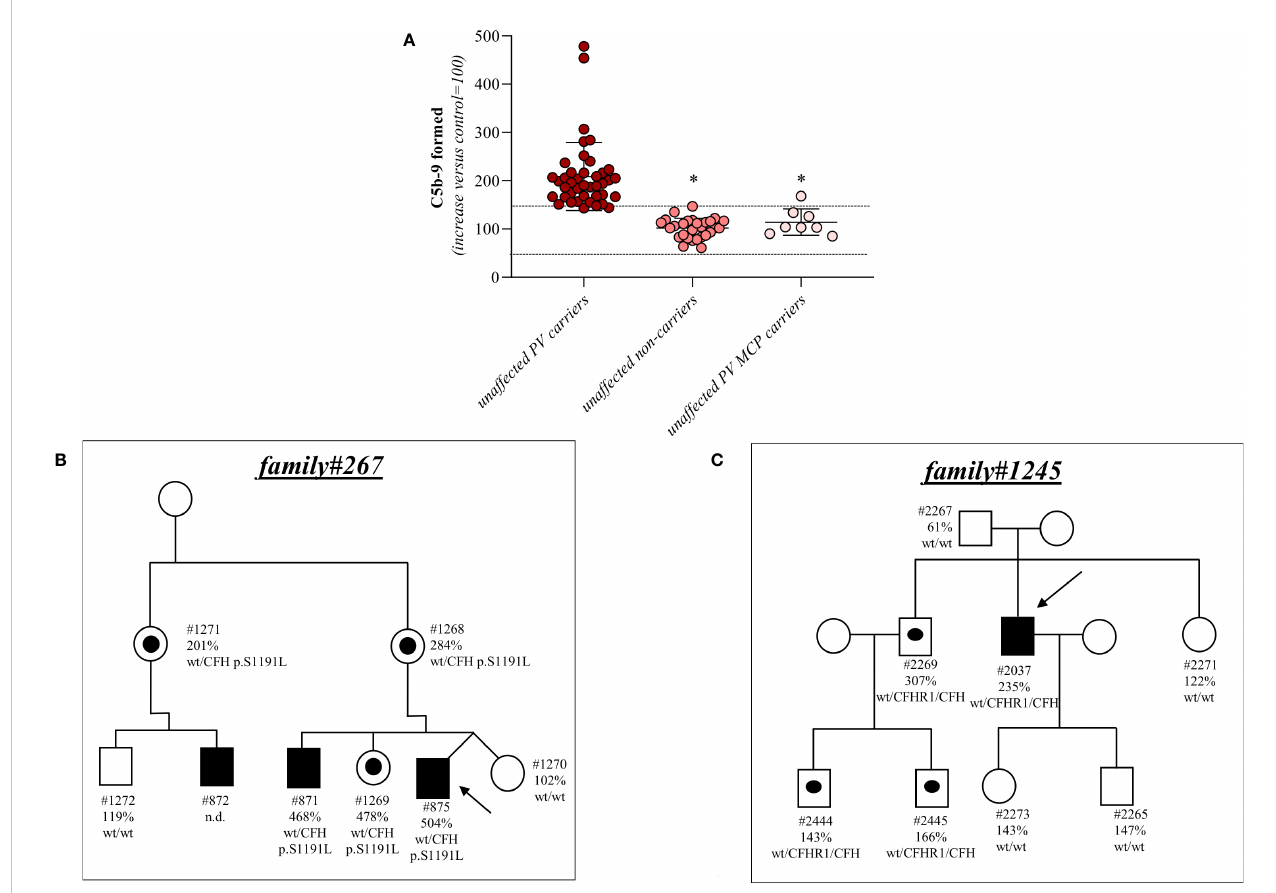
FIGURE 2 Serum from unaffected relative carriers of PV induces higher than normal C5b-9 formation on HMEC-1. (A) Endothelial surface area covered by C5b-9 staining after 2h incubation of ADP-activated HMEC-1 with serum (diluted 1:2 in test medium) from either unaffected carriers of PV in genes encoding for fl uid phase complement proteins (n=41), or from unaffected non-carriers of PV (n=28) or from unaffected carriers of PV in the MCP gene only (n=8). The results are shown as the fold increase of stained surface area after incubation with serum from unaffected carriers versus control pool of sera run in parallel. Points represent fold increase values of single subjects. Horizontal bars are mean ± SD values. Dotted lines are upper and lower limits of normal range. *P<0.0001 vs. unaffected carriers of PV. (B) Pedigree #267 of aHUS proband #875 (indicated by the arrow) with a PV in CFH p.S1191L. The same PV was found in his brother (affected, #871), his mother (#1268), his sister (#1269), his uncle (#1271) and his cousin (affected, #872). (C) Pedigree #1245 of aHUS proband #2037 (indicated by the arrow) with a pathogenic CFHR1/CFH hybrid gene ( CFHR1 1-4 -CFH 22-23 ). The same hybrid was also found in his brother (#2269) and his nephews (#2444 and #2445). In each pedigree, the affected subjects are in black, healthy carriers of PV are identi fi ed with a black dot. The circles indicate females and the squares indicate